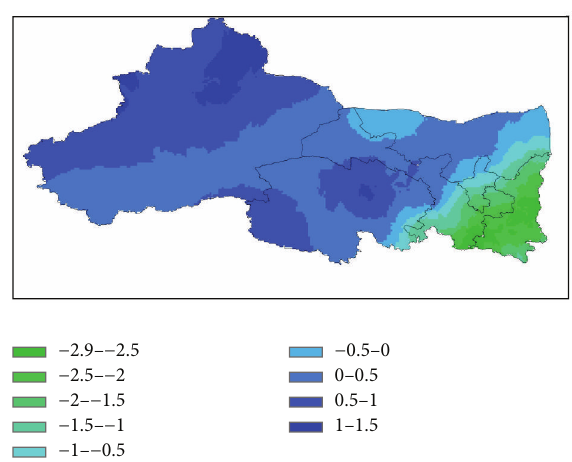
Figure 2: Spatial distribution of 𝛽 -values for annual mean pre- cipitation during 1960–2008. Quantities show changes in annual precipitation in mm per